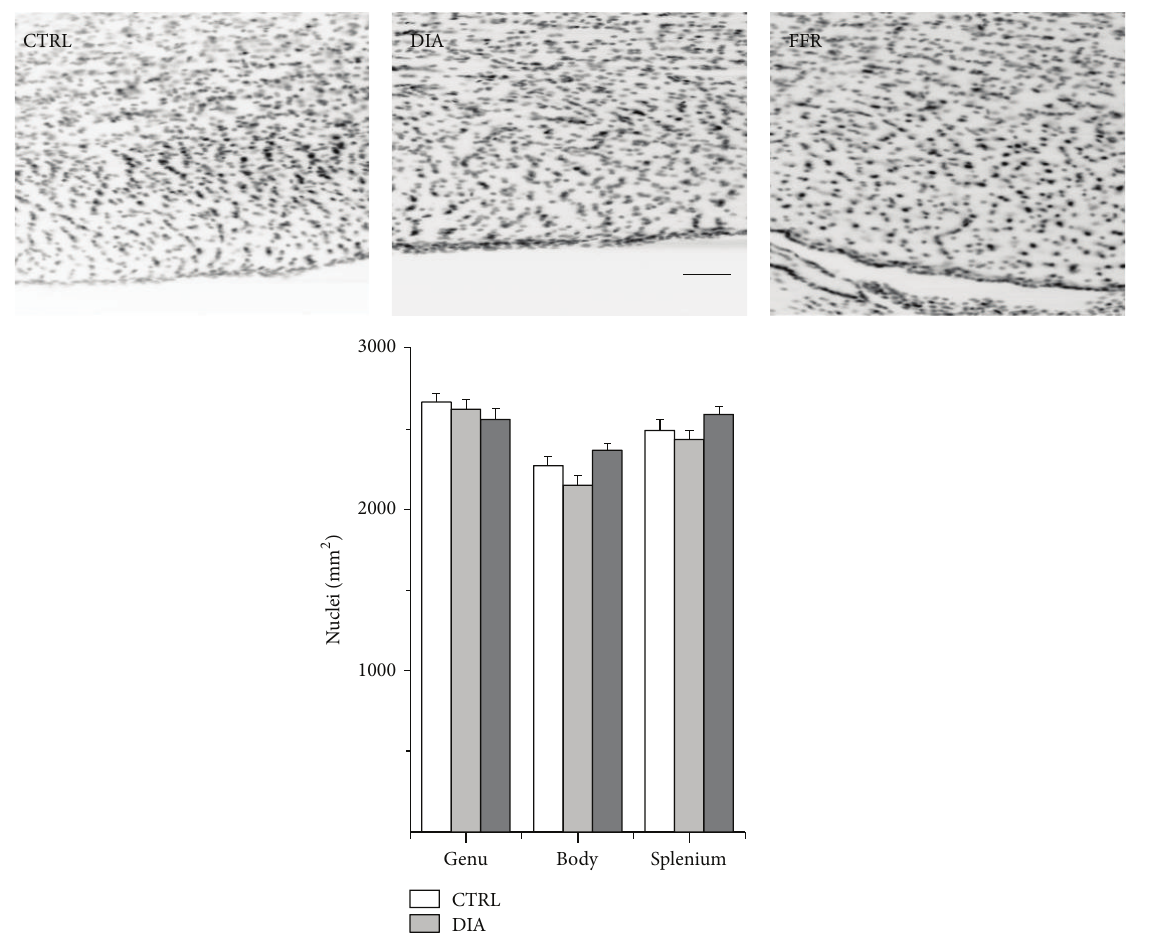
Figure 2: Dehydration-induced anorexia (DIA) has no effect on glial cell density. Sagittal sections of the body of the rat CC show DAPI staining in control (CTRL), dehydration-induced anorexia (DIA) and forced food-restricted (FFR) groups. The density of nuclei did not differ significantly among the three experimental groups in the genu ( 𝑛 ≥ 23 ), body ( 𝑛 ≥ 26 ), or splenium ( 𝑛 ≥ 20 ). Scale bar = 100 𝜇 m. Data are mean ±